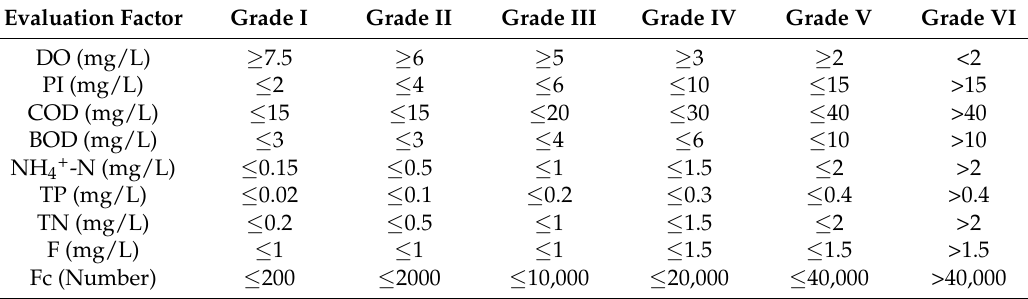
Table 1. Quantitative boundaries of water quality grades of all criteria [34].